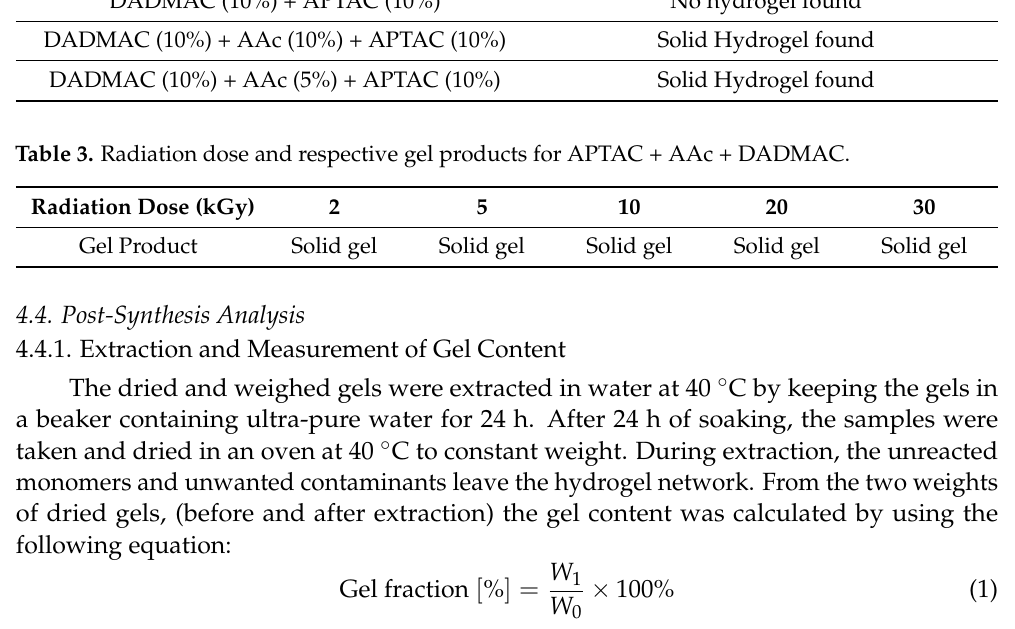
Table 2. Different composition of raw materials and observation after gamma irradiation. Composition of Raw Materials